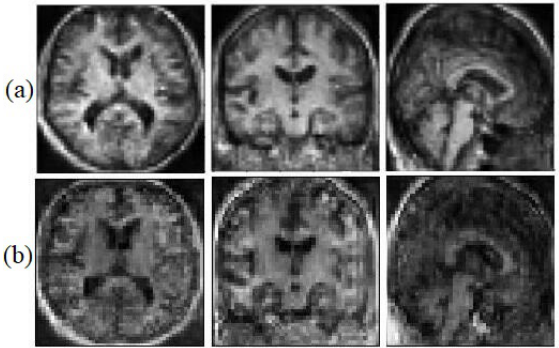
Figure 6. Synthetic MRI with the Sobel filter ( a ) and without the Sobel filter ( b ).